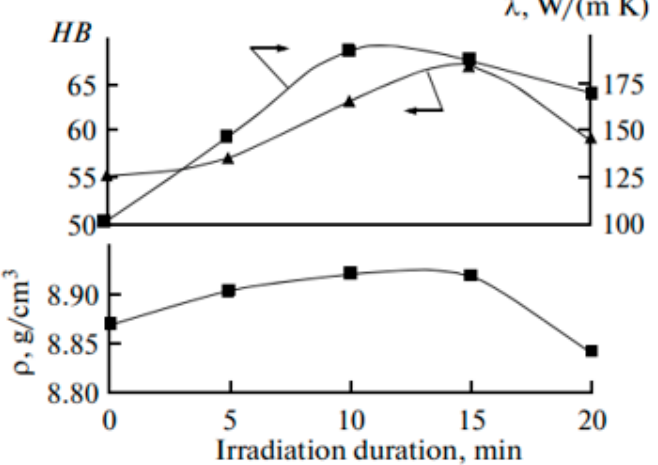
Figure 18. Dependence of the physical–mechanical properties of tin bronze on the EMP irradiation duration of its melt [46].